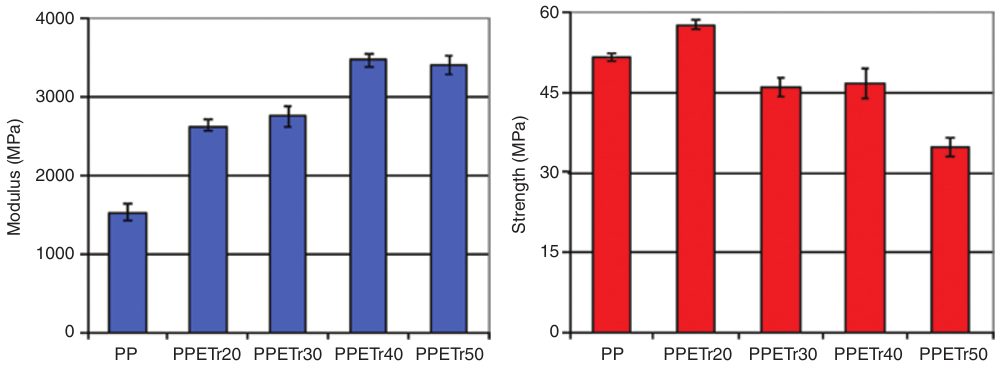
Figure 9 Flexural properties of PP triticale composites with different triticale concentrations.